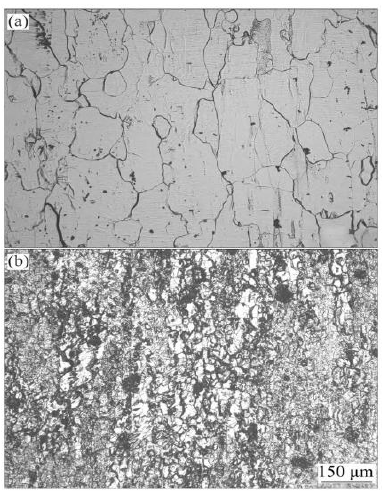
Figure 5. Optical microstructures of the two studied alloys with solution treatment: ( a ) 0%Gd and ( b ) 0.25%Gd. Adapted with permission from ref. [46]. 2012 Mei et al. ( b ) 0.25% Gd. Adapted with permission from ref. [46]. 2012 Mei et